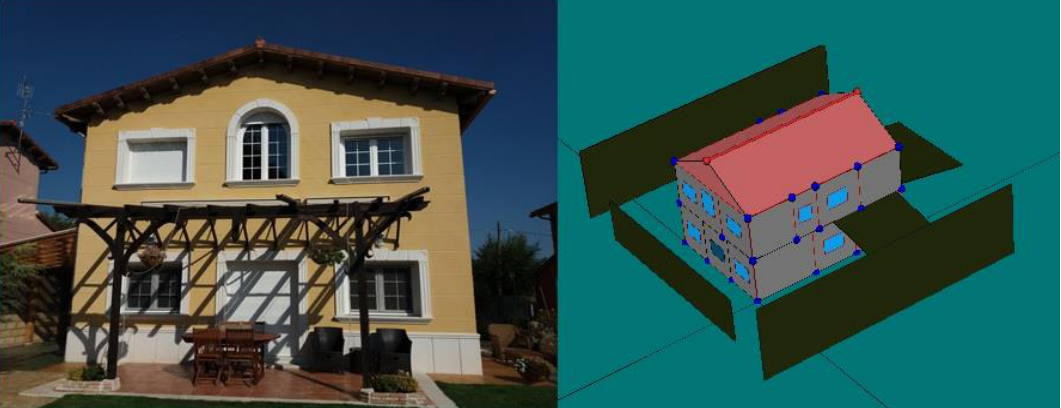
Figure 4. Model of studied case.